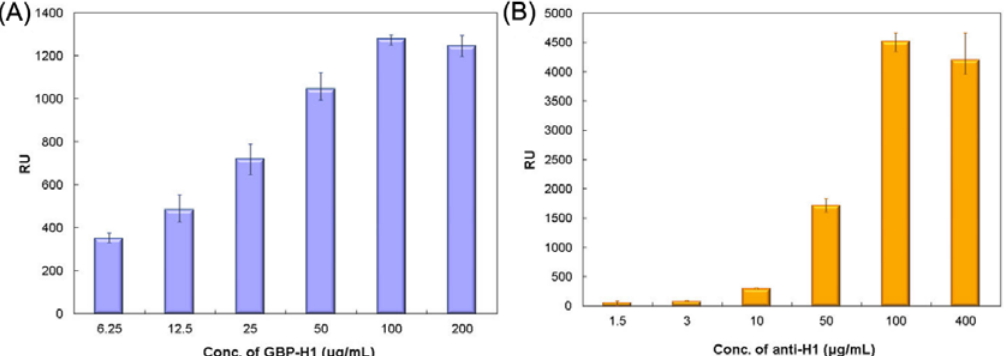
Figure 3. Molecular binding optimization of GBP-H1a fusion protein and its specific Ab with different concentrations. ( A ) Specific bindings of GBP-H1a fusion protein onto the gold surface. ( B ) Subsequent bindings of anti-H1 Ab. The bindings were started at 150 s and the unbound samples were washed at 750